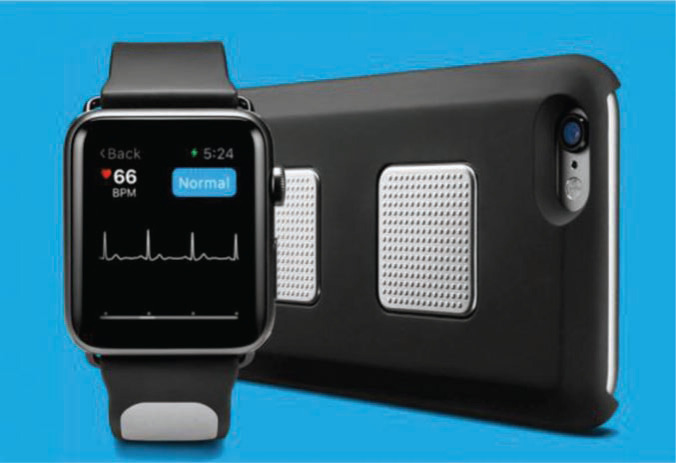
An AF-sensing smartwatch (not FDA approved) and smartphone adaptor (FDA approved).